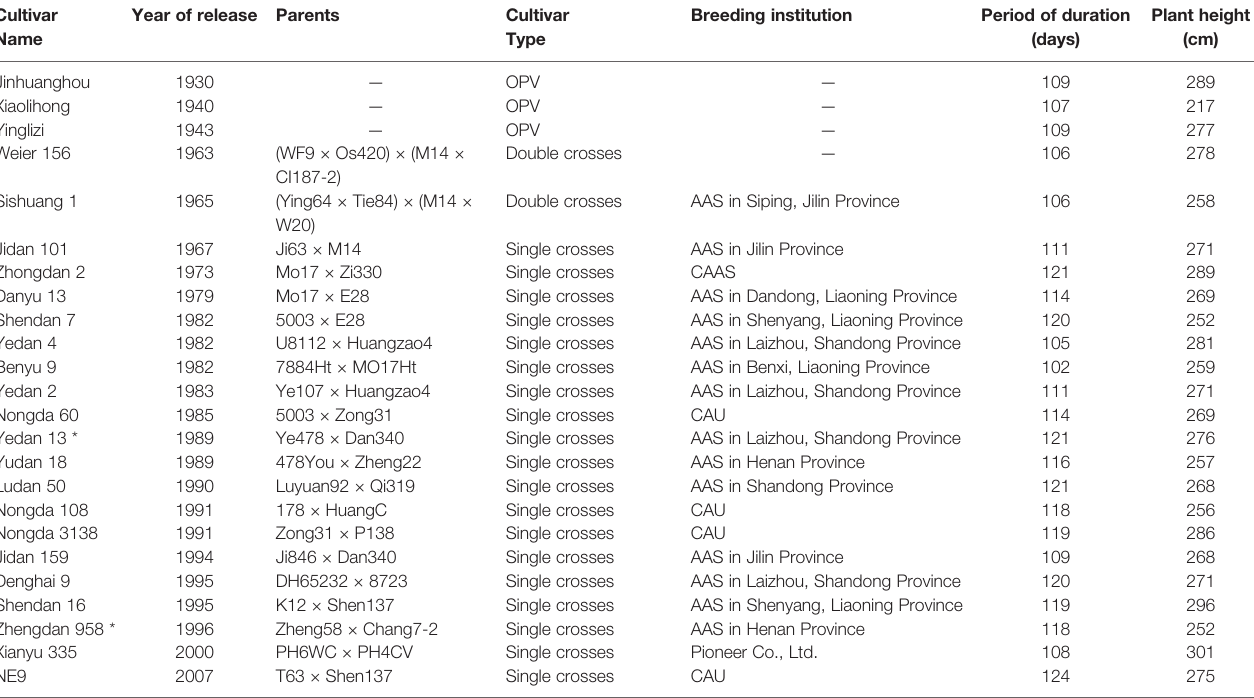
TABLE 1 | Characteristics of cultivars used in the experiments. Cultivar